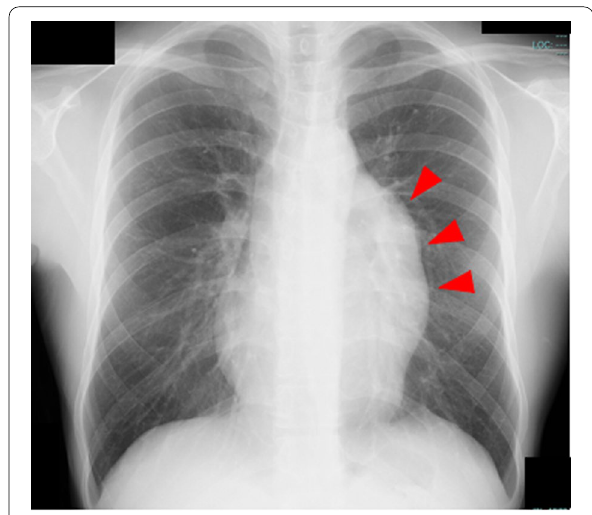
Fig. 1 Pre-operative chest X-ray showed an abnormal mass in the left hilum region (arrowheads)